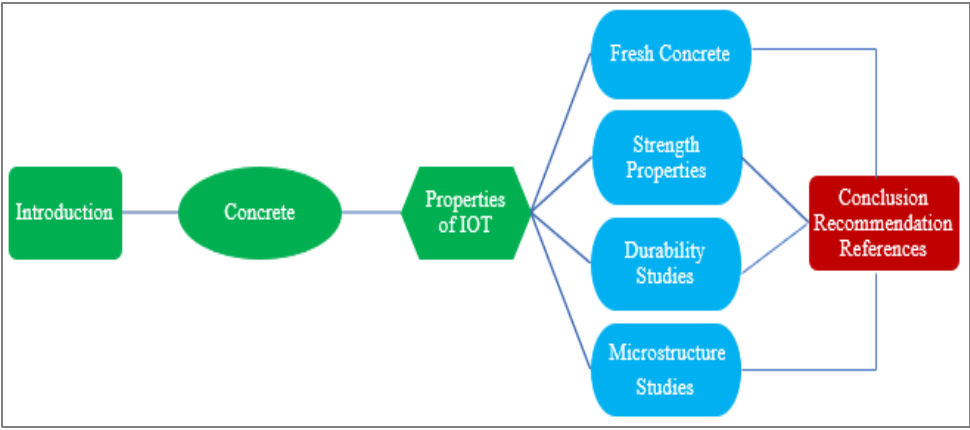
Figure 2. Different sections of the review.